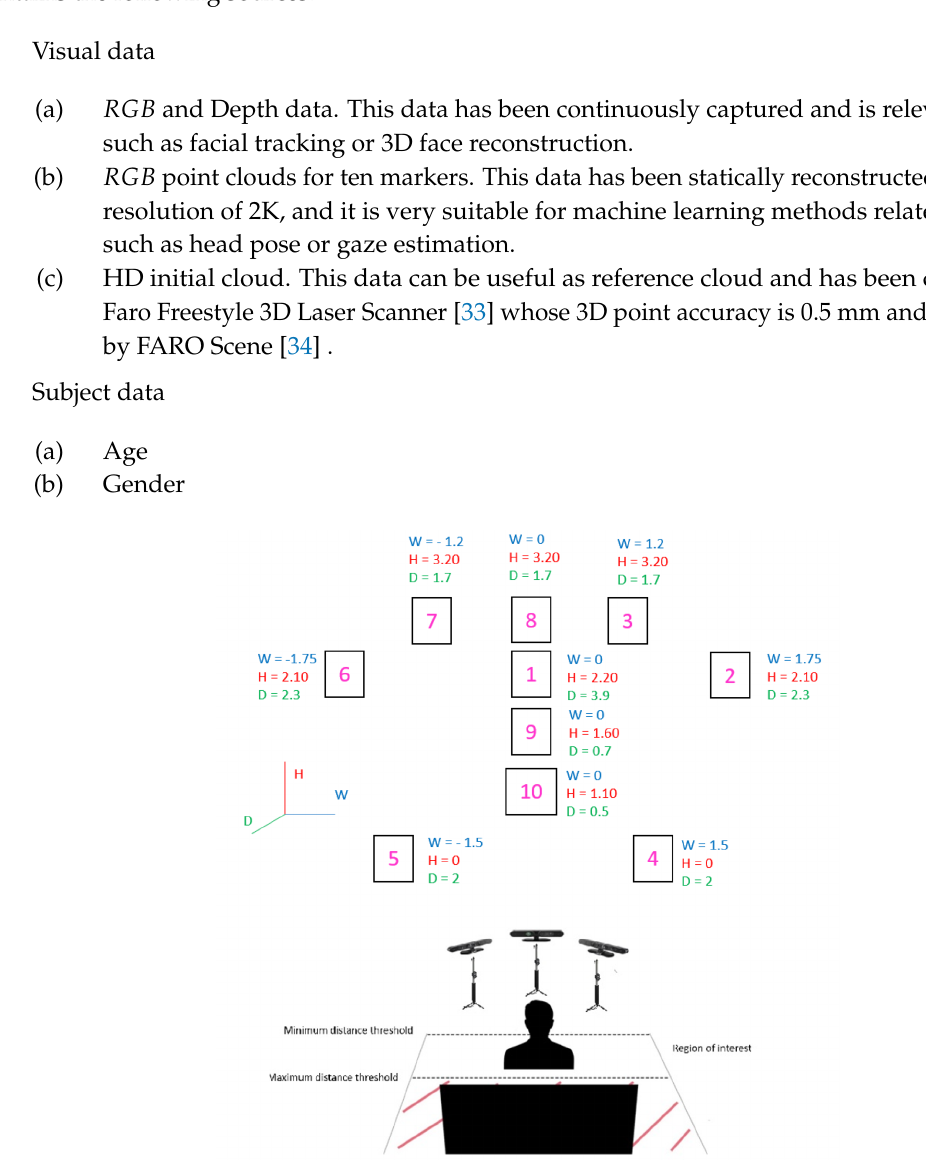
Figure 1. Graphical description of the proposed scenario to capture the 3DWF dataset. Coordinates of the markers are expressed in